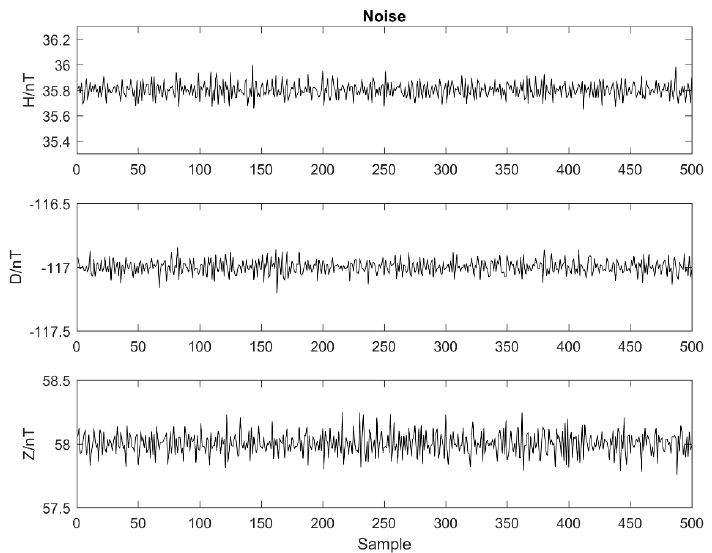
Figure 11. Three-component data waveform from the prototype fluxgate sensor in the shielding cylinder. Table 3. Noise test results.